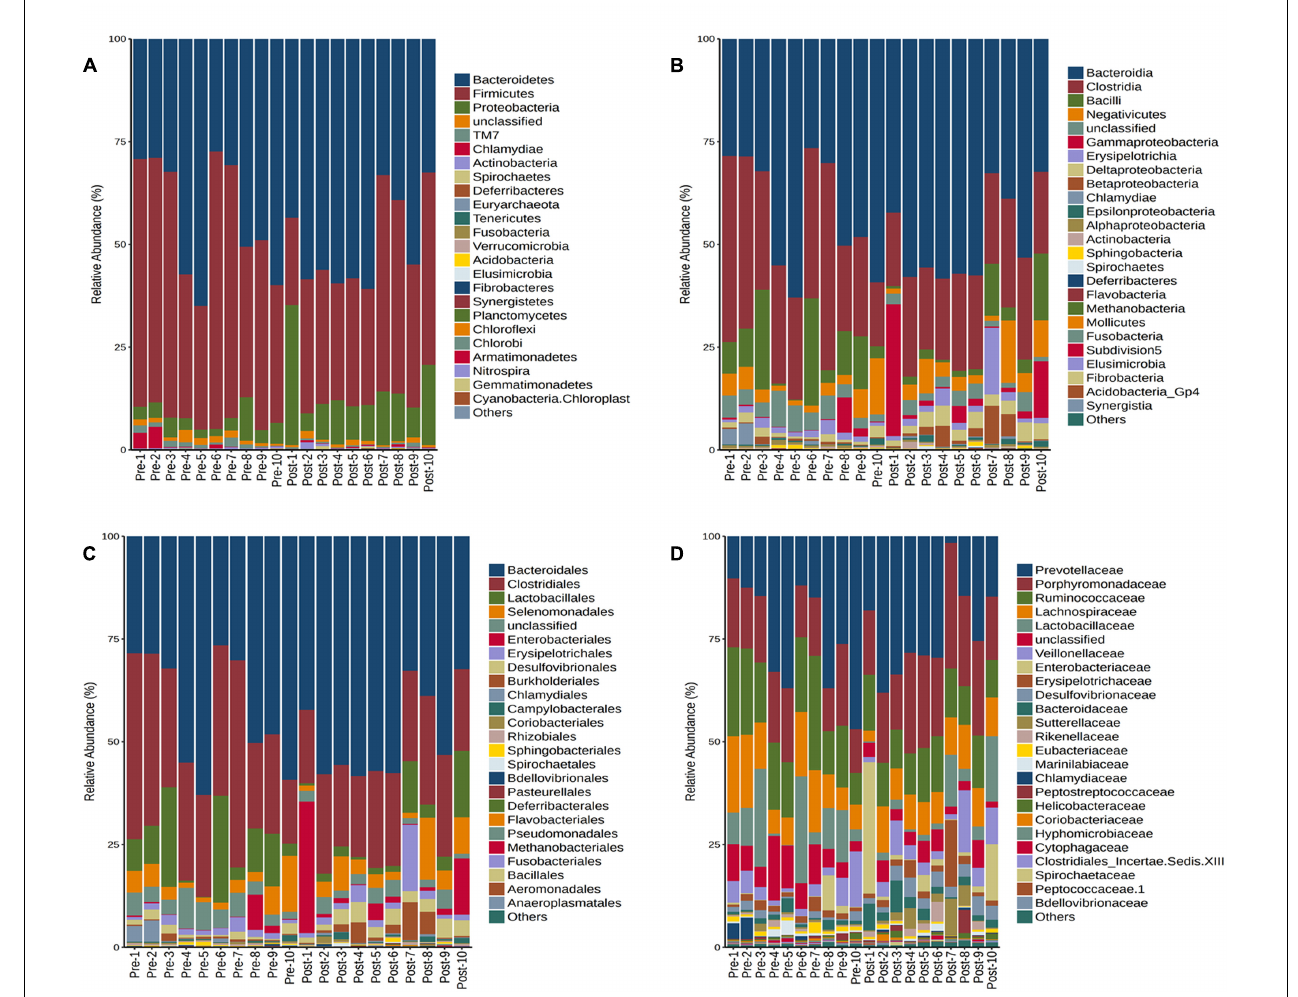
FIGURE 5 | Taxonomic assignments of the bacterial tags from the two groups (pre- and post-burn) in Phylum (A) , Class level (B) , Order (C) , and Family level (D) . BurnB1 denotes the result for rat number 1 pre-burn, while BurnA1 denotes the result for rat number 2 post-burn and so on up to BurnB10 and BurnA10. The bar indicates the bacterial classification at each level.